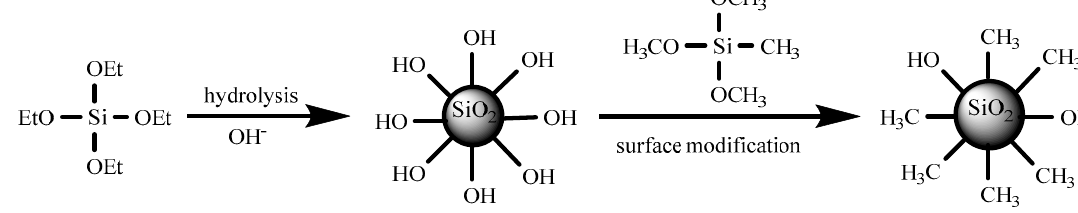
Figure 1. Schematic of the preparation of the methylated silica sol.